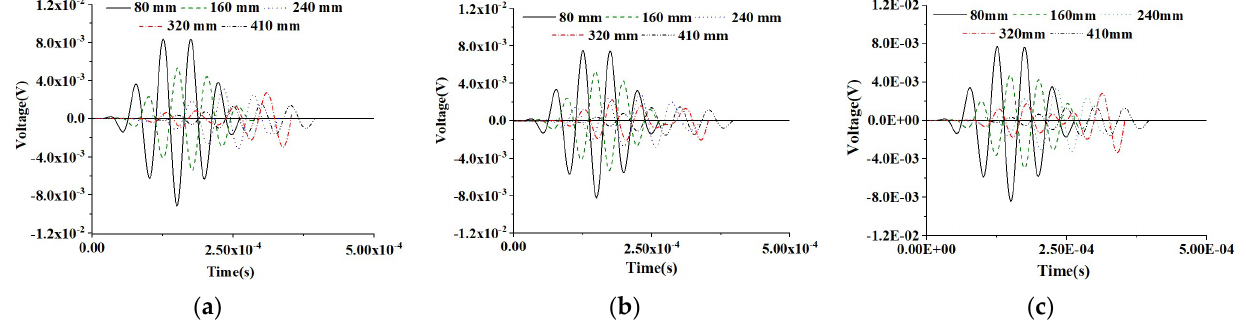
Figure 8. Output voltage collected by sensors at different measurement distances from the actuator under a modulated excitation signal for healthy CMFEMs. ( a ) CMFEM 1; ( b ) CMFEM 2; ( c ) CMFEM 3.